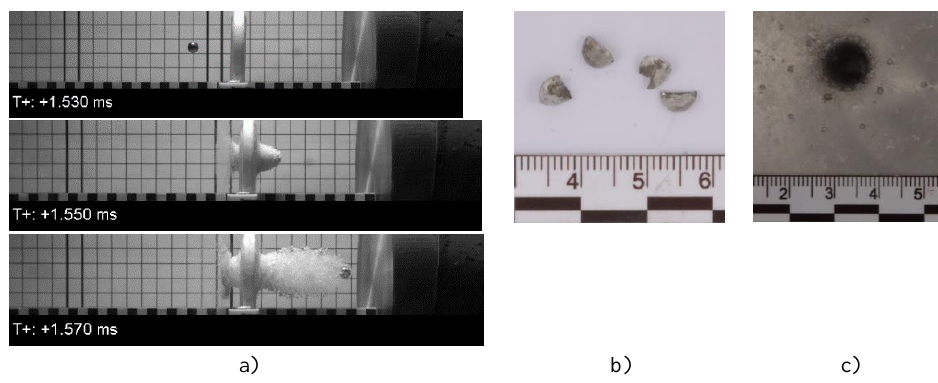
Fig 6. The photographic record of the plexiglass penetration ( a ), the drummer fragments ( b ) and the front of the barrier–“witness” ( c ) after the collision at V 0 = 2014 m/s The simulation of this experiment is shown in Fig. 7. In this calculation, at time t = 10.0 mcs, as in the experiment, material is ejected from the back of the sample. The destruction of the drummer into fragments under the conditions of modeling in an axisymmetric formulation cannot be described. However, the figure shows the zone of tensile strains, which indicates the material destruction. The depth of the crater formed is h = 21.28. The accordance with the experiment on the depth is 4.2%, on the velocity after the interaction with sample – complete match.